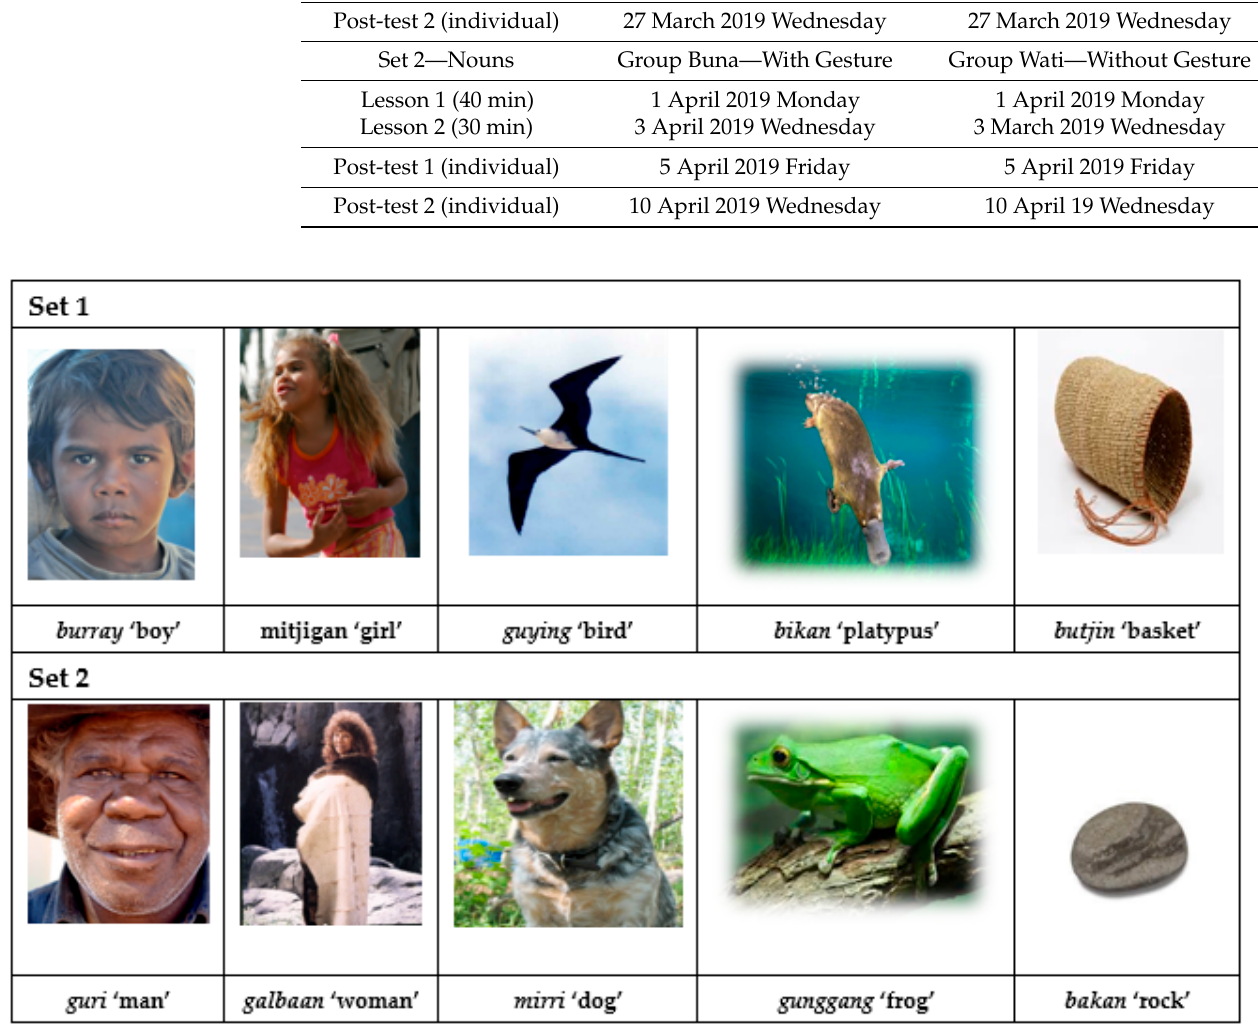
Figure 1. Noun sets.